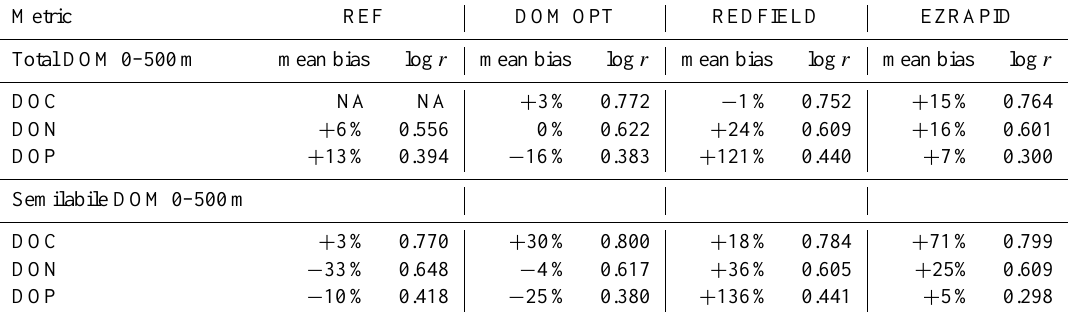
Table 4. DOM mean bias and correlation coefficient in relation to the DOM observations within the upper ocean (0–500m depth) for the REF, DOM OPT, REDFIELD, and EZRAPID ∼ 3 ◦ simulations. Observations of semilabile DOM are calculated as the total observed DOM concentration less the asymptotic concentration below 1000m in each ocean basin.